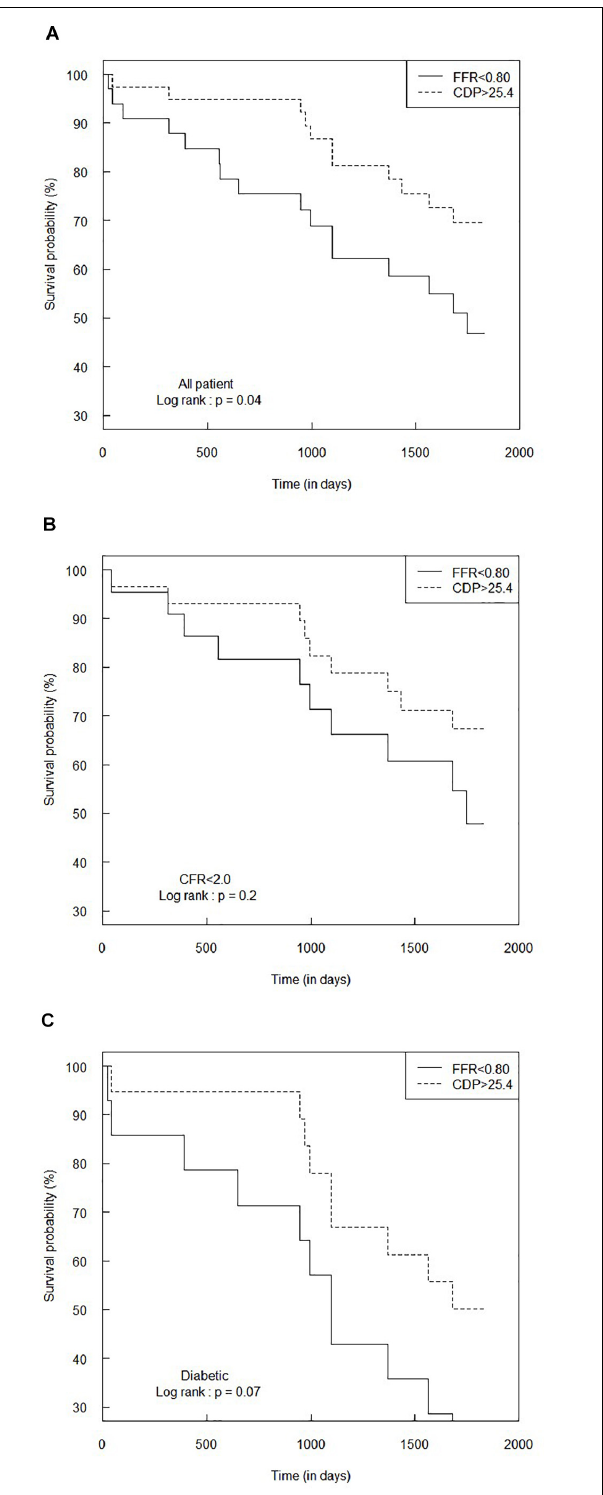
FIGURE 5 | Comparison of Kaplan–Meier survival curves between FFR < 0.75 and CDP > 27.9 groups for (A) the all-patient group, (B) CFR < 2.0 sub-group, and (C) diabetic sub-group. The p -values are provided for the log-rank test. CDP, pressure drop coefficient; FFR, fractional flow reserve.